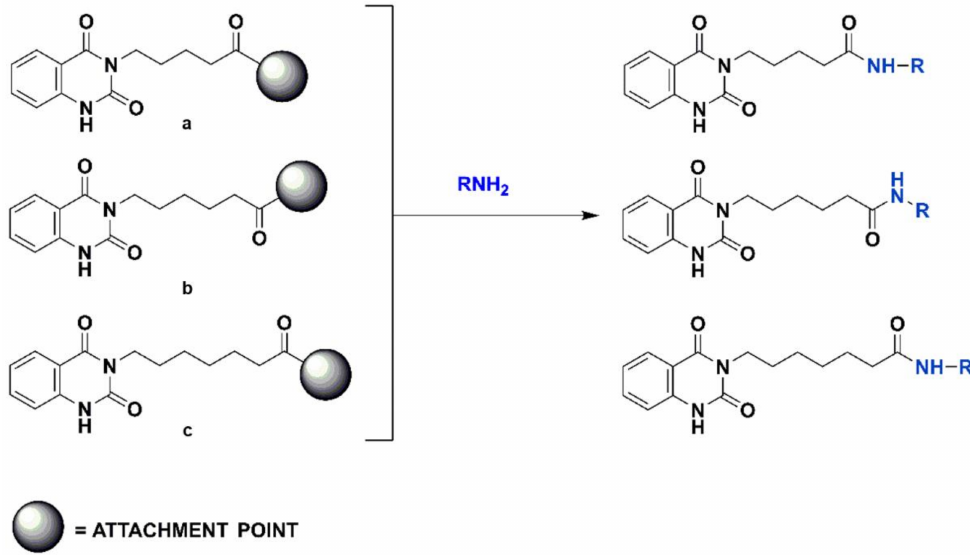
Figure 3. Scheme of the generation of the combinatorial